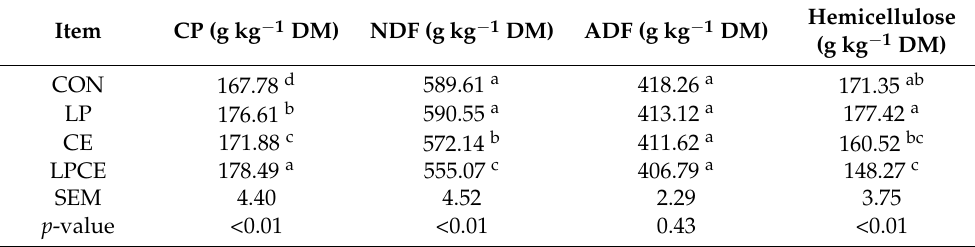
Table 3. Effects of additives on the chemical compositions of silages after 30 days of